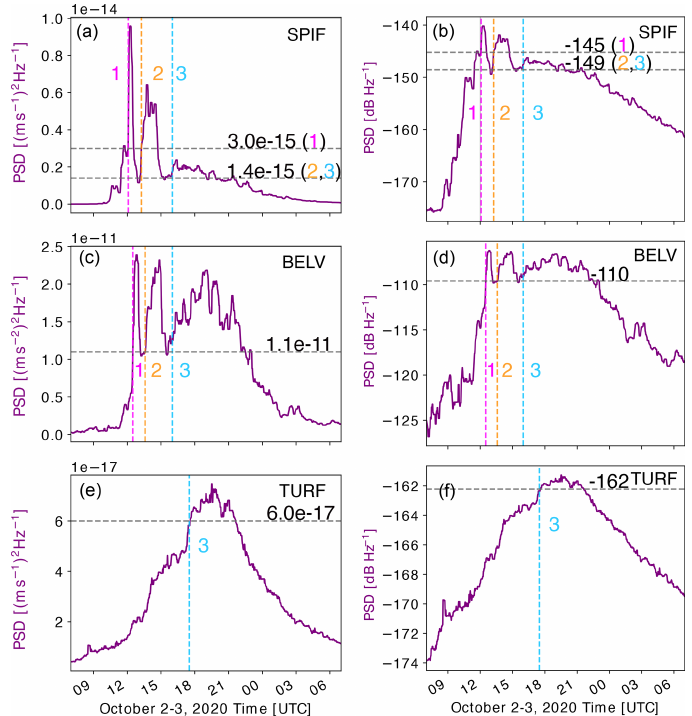
Figure B4. Seismic power (PSD) recorded at SPIF, BELV, and TURF seismic stations on a linear scale (a, c, e) and logarithmic scale (dB; b, d, f ). The seismic power is averaged in the 1–20Hz frequency band, between 07:00UTC on 2 October and 07:00UTC on 3 October. Vertical lines show the starting hours of the three peaks, and the horizontal lines show the threshold used to define the